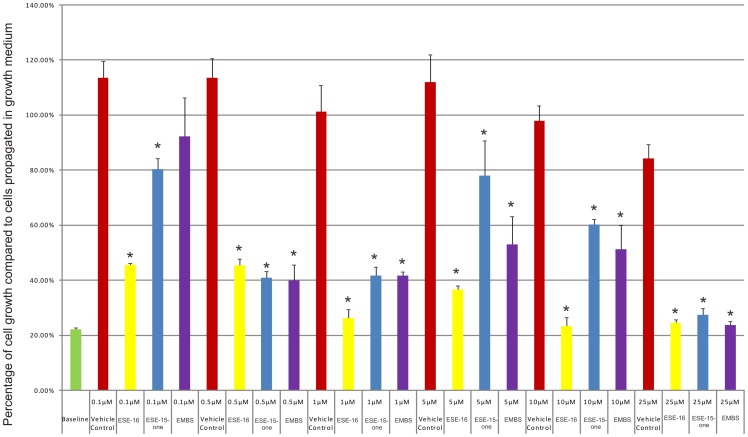
Cell number determination.HeLa cell numbers expressed as a % of cells relative to the control (cells propagated in growth medium) after exposure to ESE-15-one, EMBS and ESE-16 for 24 h. An asterisk (*) indicates a statistically significant P-value of <0.05 when compared to cells propagated in growth medium.